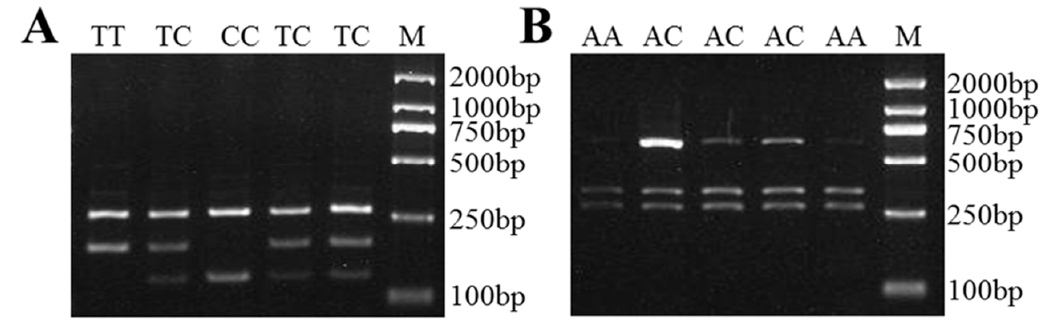
Figure 5. The PCR-RFLP results for the different genotypes of sheep LCORL . The genotypes are